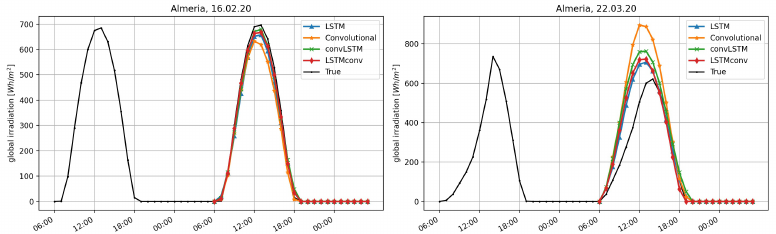
Figure 9. Global irradiation forecasts for Almeria on 16 February 2020 (left) and 22 March 2020 (right).